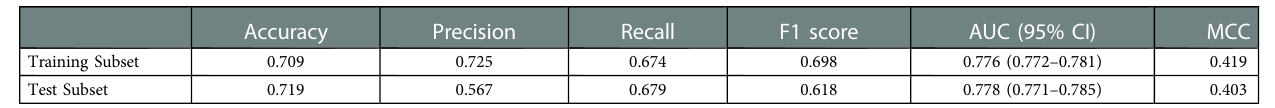
TABLE 4 The prediction performance of the risk score model in the training subset and test subset. Accuracy